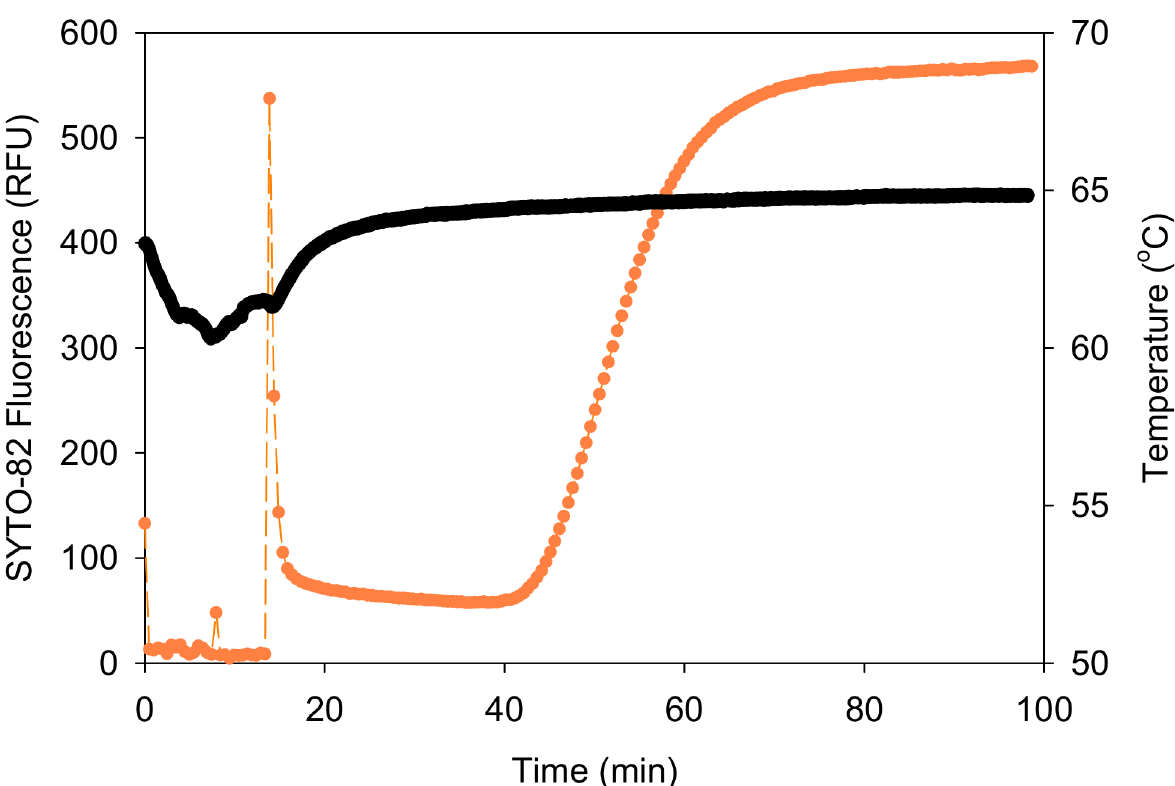
Fig 6. Example raw data from integrated extraction and amplification assay. Fluorescence (orange) and temperature (black) were recorded during extraction of TB DNA from a high concentration PATH surrogate sputum sample and LAMP amplification. During the extraction phase of the assay, the temperature was transiently reduced by approximately 5°C as the room temperature tubing passed through the block. The peak in fluorescence at approximately 15 minutes indicated that the reaction chamber of the tubing was positioned correctly in the heat block as the amplification phase of the assay